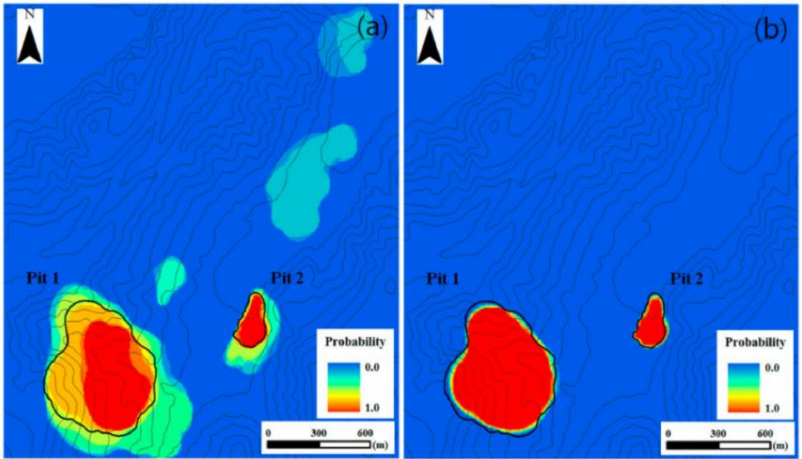
Figure 4. Probability model representing uncertainty in pit optimization results. ( a ) Case 1 considers the variation in copper prices only. ( b ) Case 2 considers the variation in zinc prices only